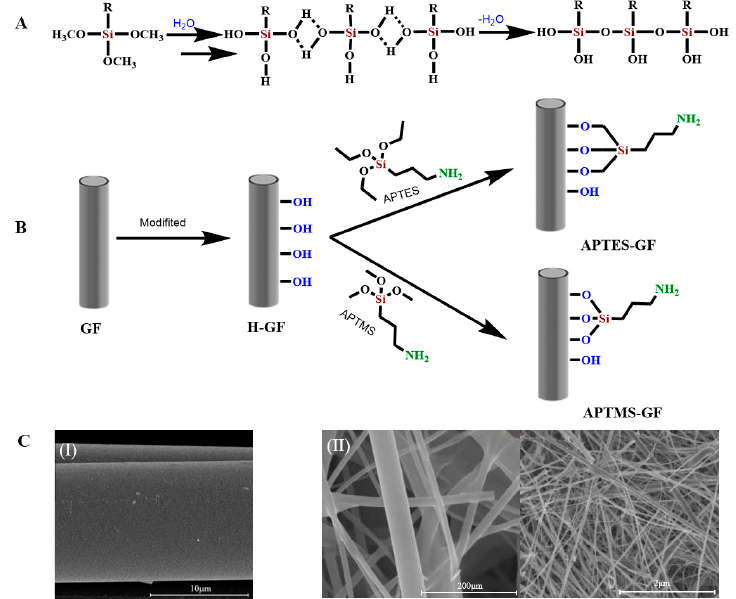
Figure 3. ( A ) The schematic of the self − condensation reaction of silane-coupling agent. ( B ) Schematic diagram of a modification of glass fiber by an amino-silane coupling agent. ( C ) SEM morphology of ( I ) APTES − GF. Reproduced with permission from reference [62]. Copyright 2014 Composites Science and Technology Society of Chemistry . ( II ) APTMS–GF. Reproduced with permission from ref- erence [64]. Copyright 2018 ChemistrySelect .